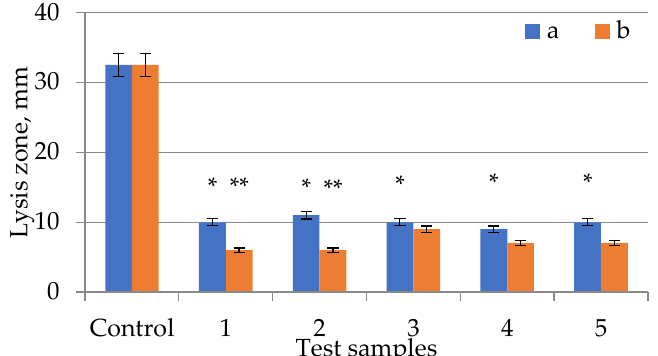
Figure 2. Testing the antimicrobial effect against Bacillus subtilis of Eucalyptus globulus extracts of different extraction times (a) with US treatment and (b) without US treatment: 1 — 10 min; 2 — 15 min; 3 — 20 min; 4 — 25 min; 5 — 30 min. Control — ampicillin (2.5 µg/10 µL). Values of the treated and control cultures followed by the symbol “*” do differ significantly ( p < 0.05) as assessed by post hoc test (Tukey test). Values of the treated culture at same time followed by the symbol “**” do differ significantly ( p < 0.05) as assessed by post hoc test (Tukey test). Values in columns/rows followed by the same letter do not differ significantly ( p > 0.05) as assessed by post hoc test (Tukey